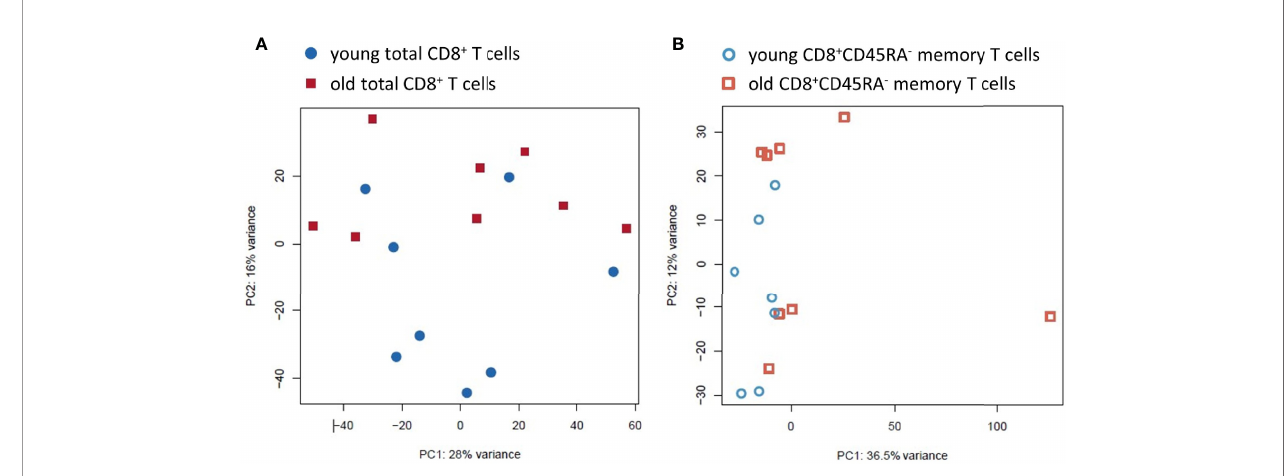
FIGURE 3 | Principal Component Analysis of the transcriptomic pro fi les of the total CD8 + T cell population and the CD8 + CD45RA - memory T cell subpopulation from young and old donors. (A) . PCA for the total CD8 + T cell preparations. The variation found was 16% and 28%, respectively. Total CD8 + T cells from young donors are blue circles, and old donors are red squares. (B) . PCA for the CD8 + CD45RA - memory T cell subpopulation. The variation found was 12% and 36.5%. The young donors are blue hollow circles and the old donors are red hollow